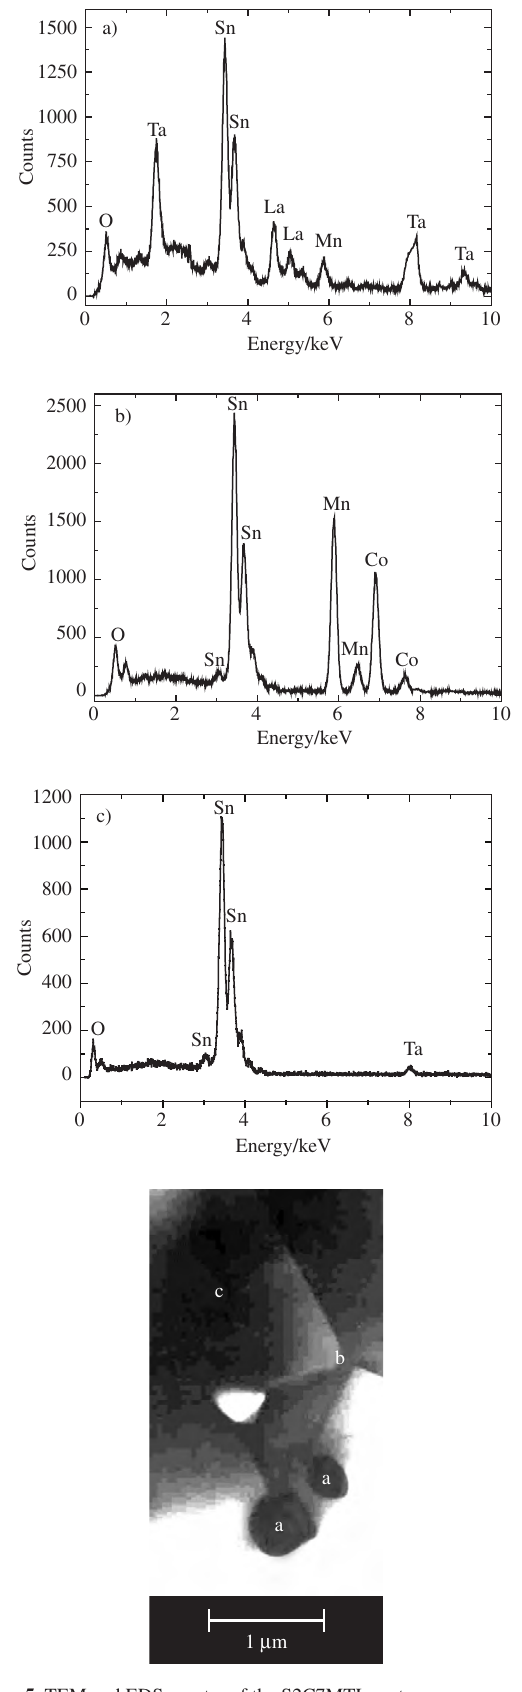
Figure 5 illustrates the microstructure obtained by TEM and EDS spectra for S2C7MTL system. The S2C7MTL system, in average, showed highly homogeneity of grains concerning amounts of tin, tantalum, cobalt and manganese elements, similarly to what was observed to S2C7MT and S2C7MTN systems. It was found higher amount of precipitates at triple points compared to S2C7MT. At grains boundaries double junctions these elements were found to be lower than those found in the S2C7MT and comparable to those found S2C7MTN systems. This behavior occurs in S2C7MTL and S2C7MTN likely because precipitates richer in Co and Mn at triple grain boundaries when are been formed consume the amount of Co and Mn elements adjacent to these regions 11 . Besides, it was observed from microstructure analysis that lanthanum presents an irregular distribution in the sample. In the precipitate points were lanthanum was found, cobalt was absent or in lower quantities compared to the points were lanthanum was not found. Similar features were found in neodymium containing systems. In the specific case of SnO .(Co ,Mn )O-based varistor compo- 2 1/4 3/4 sition in which there are two dopants used to improve densification, CoO and MnO, the addition of rare earth dopants can cause deleteri- ous precipitation leading to lower nonohmic properties. In the case of SnO .MnO, according to what was discussed in the literature 10,13 , 2 the nonohmic properties are controlled by the distribution of differ- ent junctions which is formed depending on the dopant and thermal treatment features. It was already showed that the SnO .MnO system 2 consists of two phases, SnO grains and Mn SnO , precipitated along 8 2 2 4 multiple grain junctions 10 and two types of SnO -SnO grain bounda- 2 2 ries were identified one rich in Mn and other poor in Mn element. It was concluded from reference 10 that the changes in the concentra- tion of Mn along the grain boundary are associated not only to grain misorientation but also to Mn diffusity along the grain boundary, which controls the junctions’ heterogeneities. Therefore, in other words, SnO -based systems doped with MnO tending to cause a more 2 heterogeneous microstructure which does not favor the nonohmic electrical properties since SnO .CoO-based system when appropriated 2 doped with La O presents a homogeneous microstructure accom- 2 3 panied by high electrical nonohmic properties 14 . From this aspect, it is important to note that the deleterious effect of neodymium and lanthanum oxides observed in this work is an armful indirect effect which explain just the properties when MnO is present.